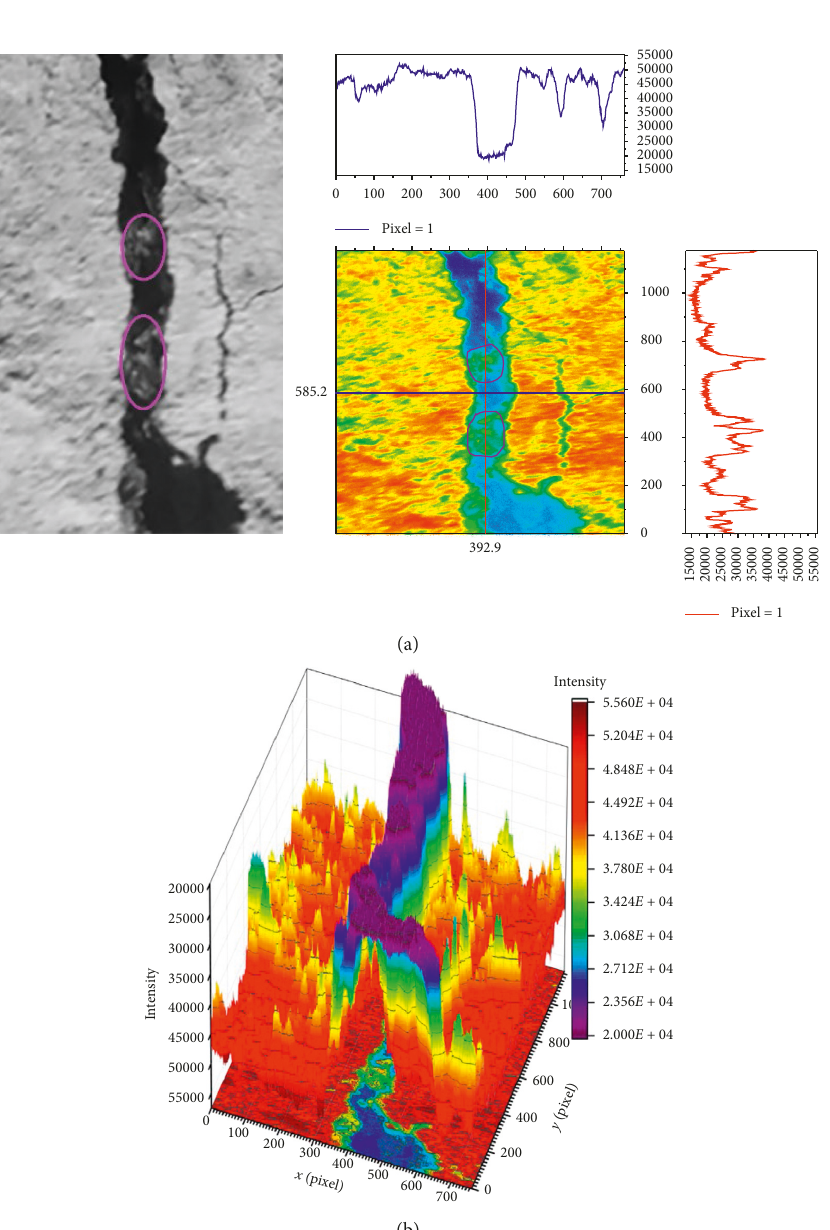
Figure 8: Gray scale image of a crack with individual particles and its 2D and 3D intensity